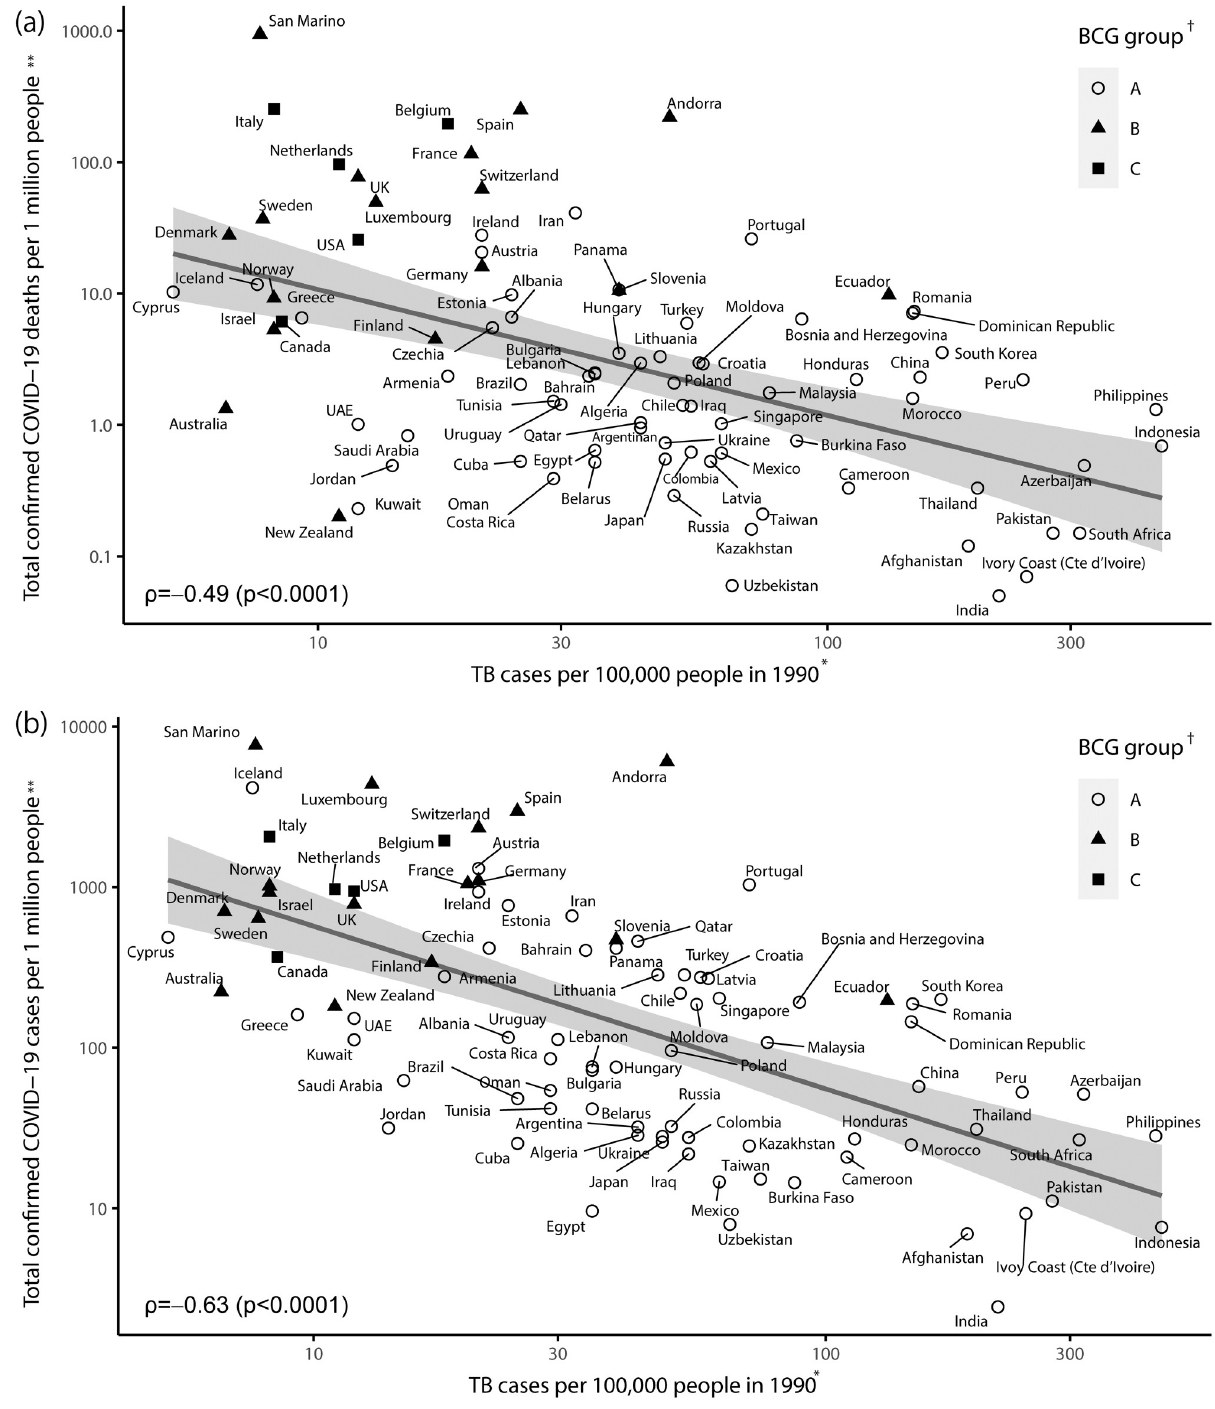
Fig 3. Scatterplot of the incidence rate of tuberculosis (TB) in 1990 versus (a) the cumulative mortality rate of COVID-19 and (b) the cumulative incidence rate of COVID-19 on 5 April 2020 according to BCG vaccination status among 90 countries. � Information was obtained from “Global Note” [12]. �� On 5 April 2020. Information was obtained from “Our World in Data” [1]. † Information was obtained from the “BCG World Atlas” [18]. A: The country currently has a universal BCG vaccination programme. B: The country used to recommend BCG vaccination for everyone, but currently, it does not. C: The country never had universal BCG vaccination programmes. Norway was moved from groups A to B [19]. TB, tuberculosis.